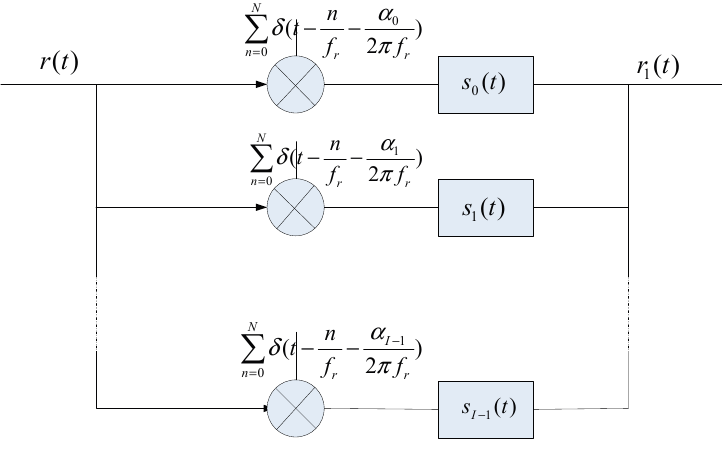
Figure 4. Reconstruction of the periodically non-uniform